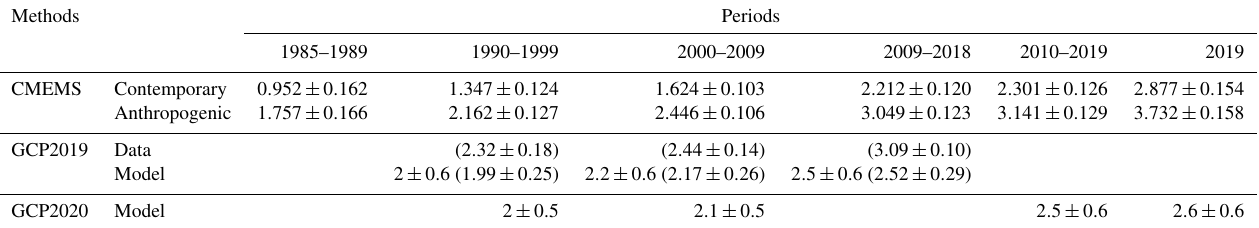
Figure 9. Yearly global integrated air–sea flux estimates derived from the CMEMS-LSCE-FFNN ensemble (mean ± uncertainty) for 1985– 2019. The multivariate El Niño–Southern Oscillation index (MEI; Wolter and Timlin, 1993, https://psl.noaa.gov/enso/mei/, last access: December 2020) is used to generally indicate a link between variations, e.g. yearly uptake–trend, in the CMEMS-LSCE-FFNN sink estimate and the ENSO climate mode (El Niño, MEI > 0.5; La Niña, MEI < − 0 . 5; neutral: otherwise). Table 3. Comparison of the global anthropogenic CO 2 uptake (mean ± uncertainty) between CMEMS-LSCE-FFNN and data-based and model-based estimates used in the Global Carbon Project (Friedlingstein et al., 2019, 2020; Hauck et al., 2020). The CMEMS-LSCE-FFNN approach provides contemporary flux estimates. Anthropogenic flux estimates are derived from contemporary fluxes adjusted with the global ocean area of 361.9 × 10 6 km 2 and the riverine flux of 0.78PgCyr − 1 . The estimates in parentheses were provided in Hauck et al. (2020) as the ensemble mean and standard deviation ( µ ensemble ± σ ensemble ) of the model- or data-based estimates. Methods